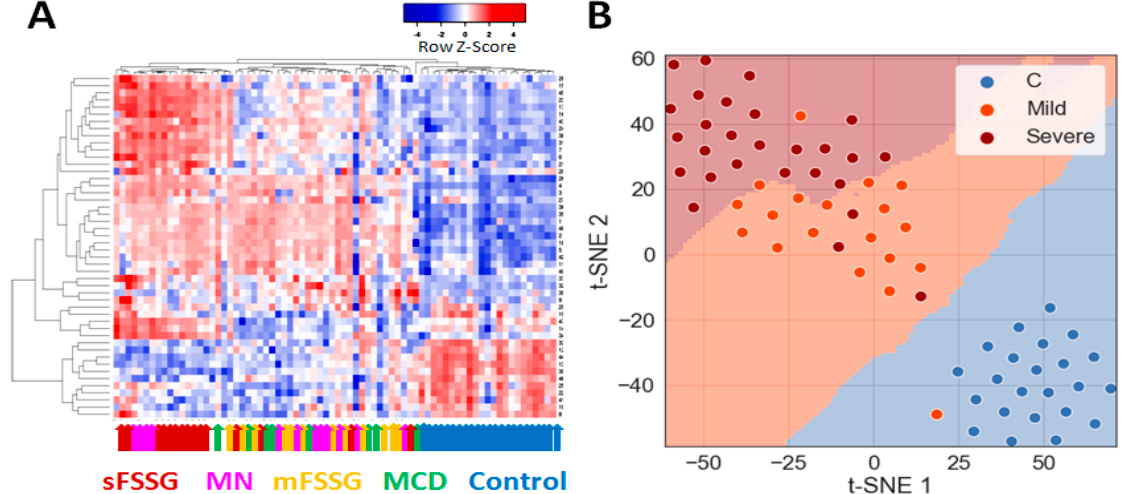
Figure 2. Boxplots for 5 urinary proteins that revealed the greatest number of differences between the control and glomerulopathy groups at FDR < 0.01 (Benjamini–Hochberg). The protein levels are shown in arbitrary units on an Ln(x + 1) scale. Abbreviations: ANT3—antithrombin-III; PLMN— plasminogen; A1AT—alpha-1-antichymotrypsin; TTHY—transthyretin; IGHG1—Ig gamma-1 chain C region.